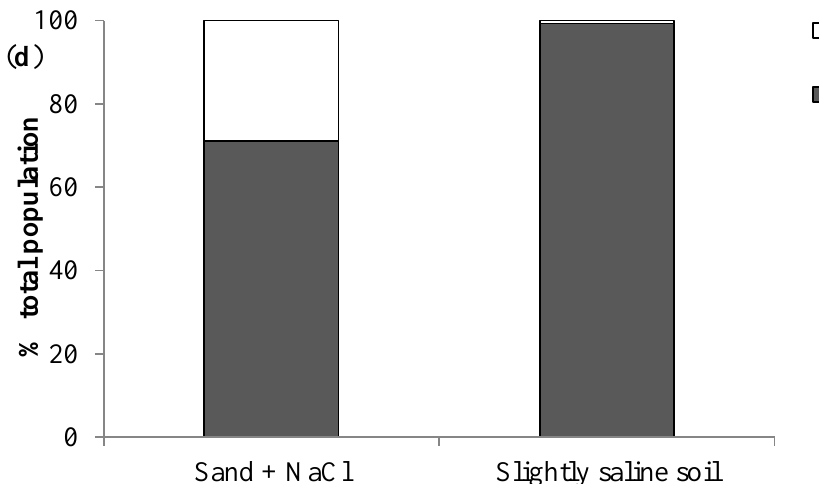
Figure 5. Competitive colonization between P. putida KT2440-Rif r and strains ( a ) EFY1-Tc r , ( b ) EFY2- Tc r , ( c ) EFY3-Tc r , and ( d ) EFY4-Tc r , in the rhizosphere of soybean plants grown in sand (watered with 80 mM NaCl saline solution) and in slightly saline soil (EC = 1.5 dS/m, watered with distilled water). Data are for plants after 10 days and are given as the proportion of KT2440-Rif r and the isolate-Tc r in the total population (means and standard deviations of our tests).